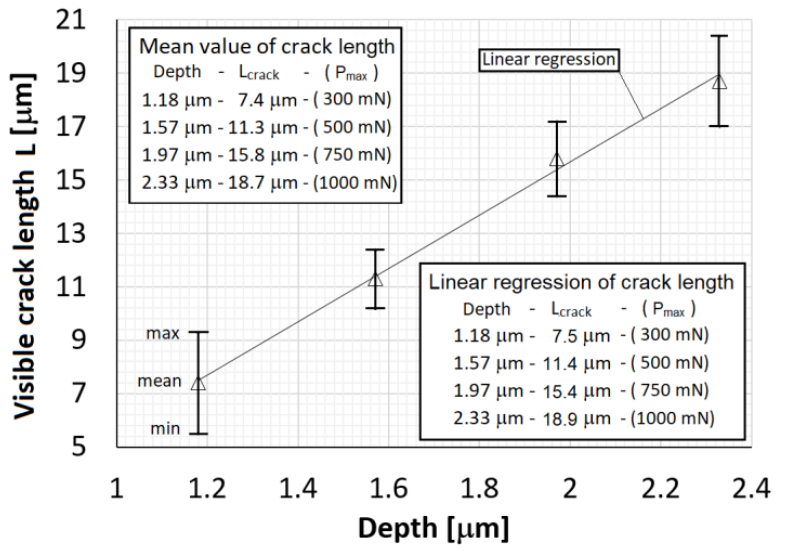
Figure 5. Experimental values of radial crack length.